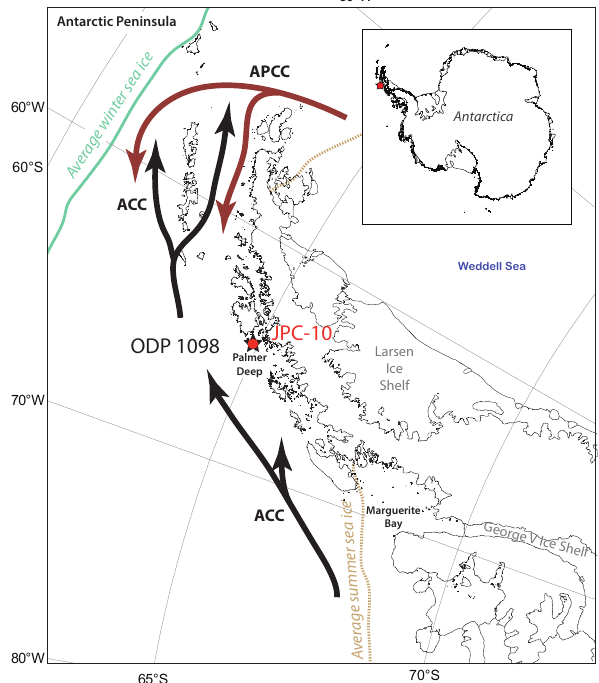
Fig. 1. Location of the JPC-10 core and the ODP Site 1098 in the Western Antarctic Peninsula (WAP). The dashed yellow line repre- sents the limit of sea ice presence during the summer while the solid green line delineates the maximum sea ice extent during the winter. Major oceanic currents: ACC (Antarctic Circumpolar Current) and APCC (Antarctic Peninsula Circumpolar Counter-current), which is derived from the Weddell Sea surface